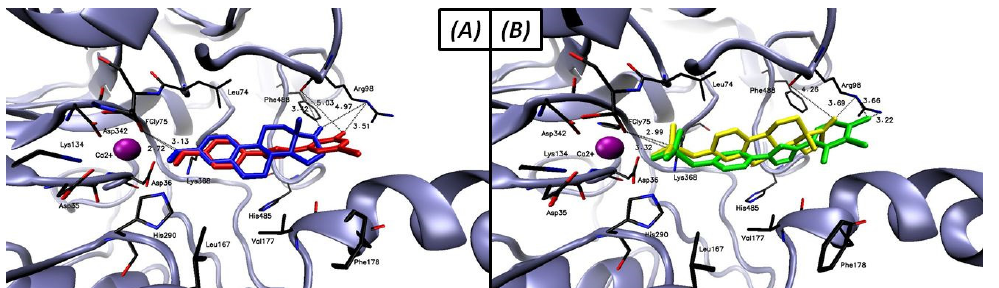
Figure 6. The binding mode of compound: ( A ) 6e (red) and E1 (blue); ( B ) sulfate of 6c (green) and E1S (yellow) in the STS active site.